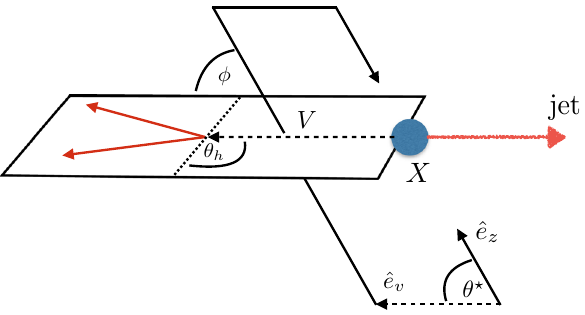
Fig. 1 Illustration of the angles sensitive to the spin and polarisation information discussed in this work. ˆ e z denotes the normalised direction of the proton–proton beam axis, ˆ e v denotes the direction of Z or γ boson in the particle X rest frame. In the case of Z + jet production the Z boson lepton decay angles include important information: θ h denotes the angle of the negatively charged lepton against the resonance X in the Z boson rest frame. φ denotes the angle between the production and decay